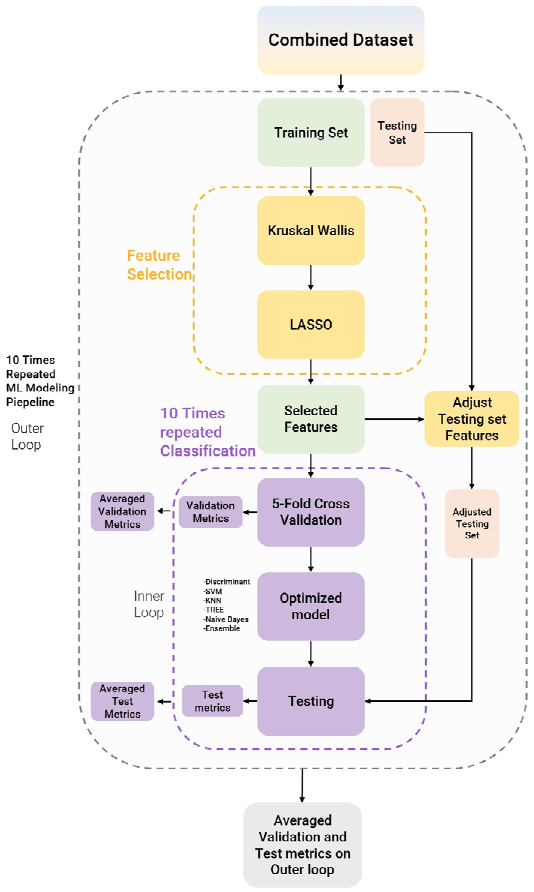
Figure 5. Modeling pipeline. The feature selection process is in yellow and the model building process is in purple.